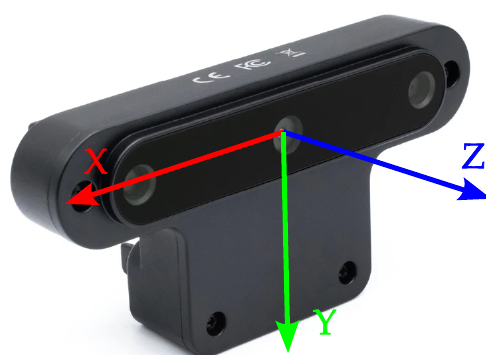
Figure 2. Reference frame used to calculate the staircase